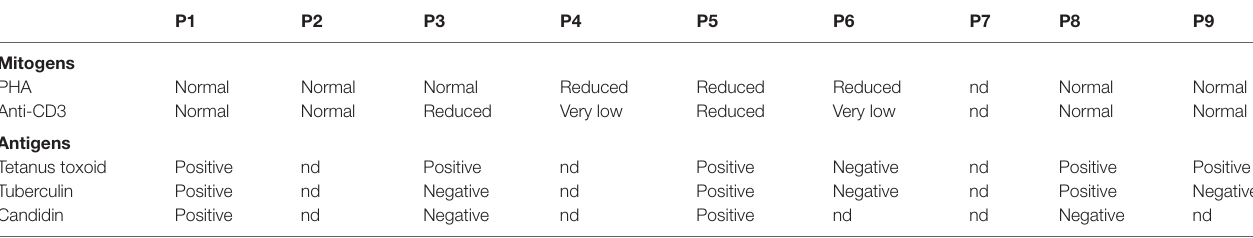
taBLe 2 | Evaluation of T cell proliferations after stimulation with mitogens and antigens. p1 p2 p3 p4 p5 p6 p7 p8 p9 Mitogens PHA Normal Normal Normal Reduced Reduced Reduced nd Normal Normal Anti-CD3 Normal Normal Reduced Very low Reduced Very low nd Normal Normal antigens Tetanus toxoid Positive nd Positive nd Positive Negative nd Positive Positive Tuberculin Positive nd Negative nd Positive Negative nd Positive Negative Candidin Positive nd Negative nd Positive nd nd Negative nd